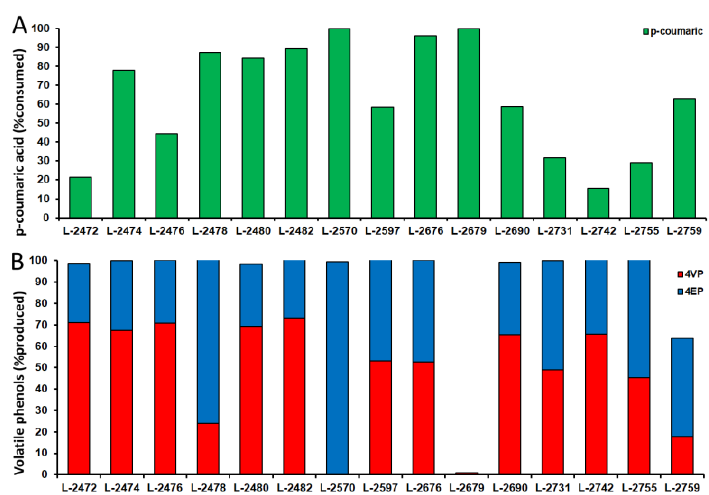
Figure 4. Relative consumption of p -coumaric acid ( A ) and relative production of volatile phenols 4-vinylphenol (4-VP) (red columns) and 4-ethylphenol (4-EP) (blue columns) ( B ) in cultures of wine strains of Brettanomyces bruxellensis from Chile.